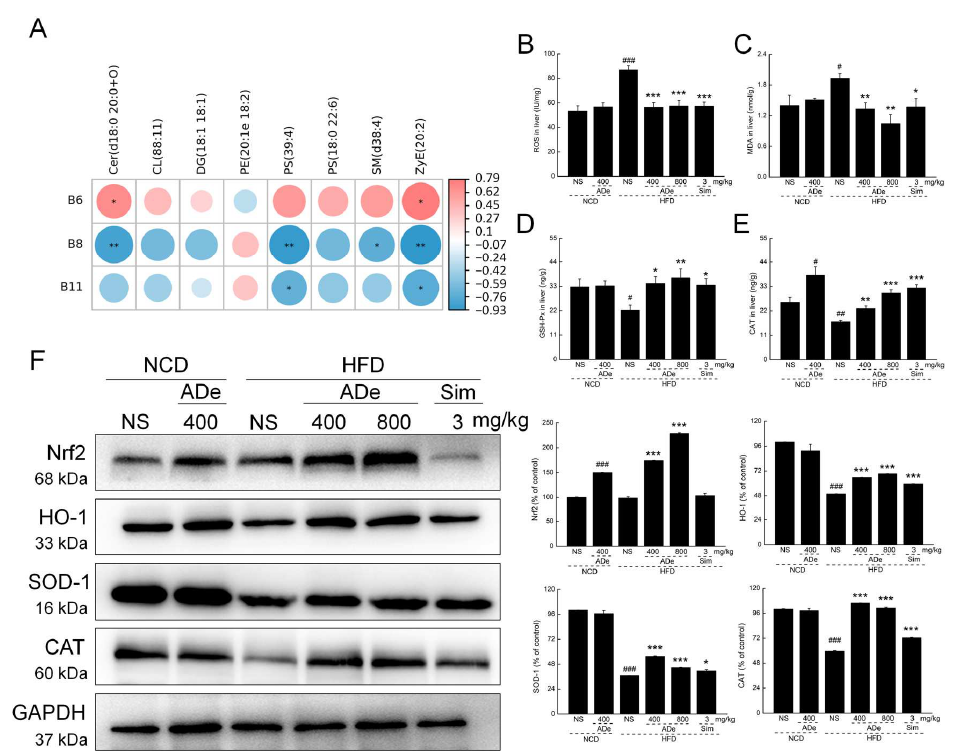
Figure 6. ADe treatment regulated oxidative stress levels. ( A ) Correlation heatmap of 8 significantly altered lipids and 19 biomarker intestinal microorganisms at the genus level based on the Pearson correlation coefficient with a p -value < 0.05 and R value > 0.75. B6: Ruminococcus , B8: Coprococcus , B11: Butyricicoccus . ADe decreased ( B ) ROS and ( C ) MDA levels and increased ( D ) GSH-Px and ( E ) CAT levels in HFD-fed mice liver. ( F ) The expression of Nrf2, HO-1, CAT, and SOD-1 in the liver were detected via Western blotting. The quantitative data of the protein expression levels were normalized to the expression of GAPDH and shown as a percentage of the corresponding relative intensity in the vehicle-treated NCD-fed mice. # p < 0.05, ## p < 0.01, and ### p < 0.001 versus NCD-fed mice; * p < 0.05, ** p < 0.01, and *** p < 0.001 versus vehicle-treated HFD-fed mice.